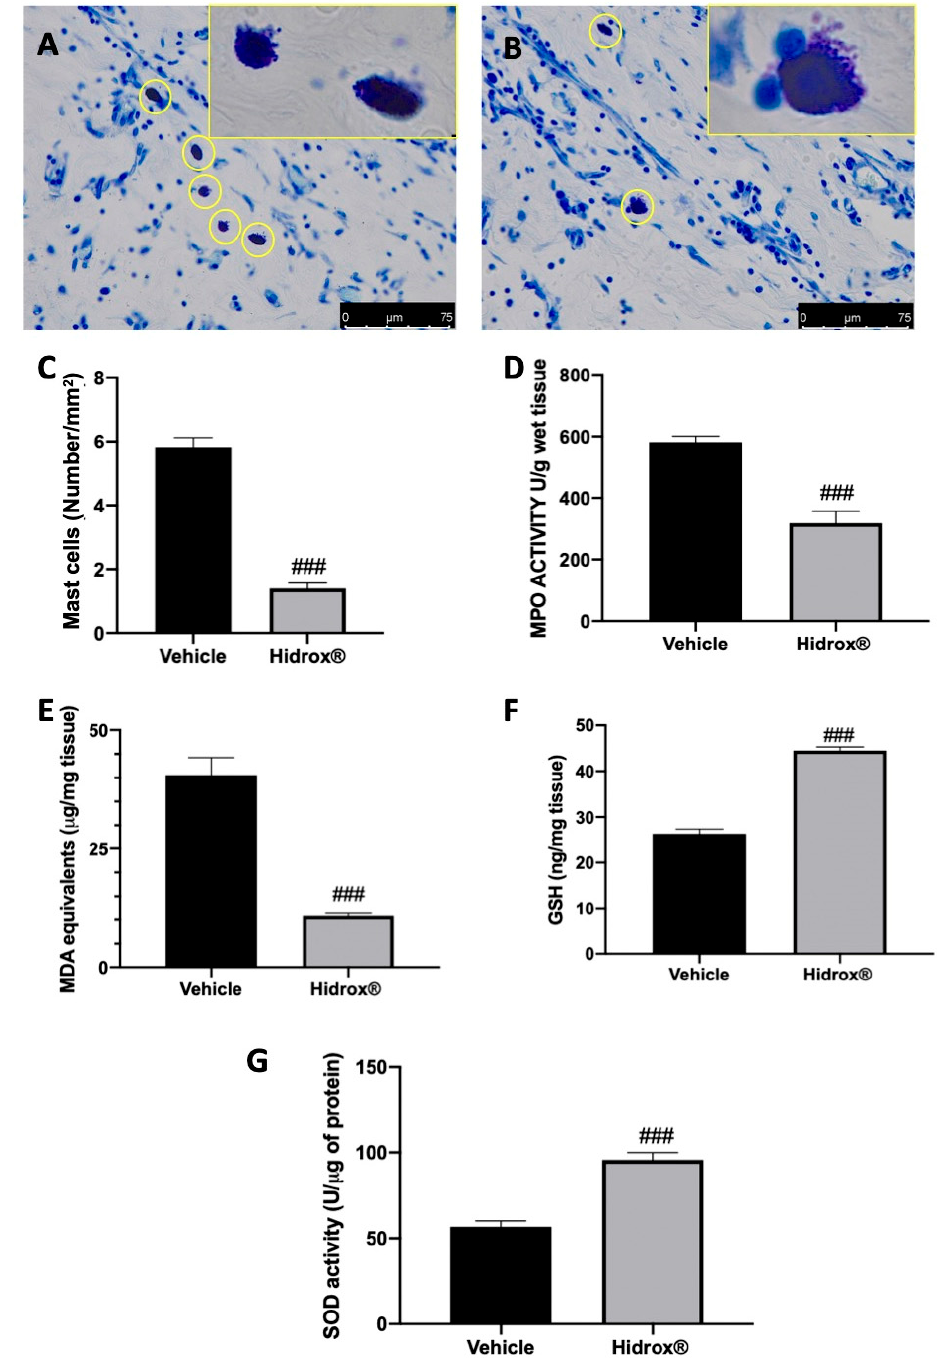
Figure 4. Hidrox ® administration reduced mast cell number and pro-oxidative alterations in endo- metrial explants: Toluidine blue staining of explanted lesions: vehicle ( A ), Hidrox ® ( B ), mast cell number ( C ), MPO activity ( D ), MDA levels ( E ), GSH levels ( F ), SOD activity ( G ). For the analyses, n = 5 animals from each group were employed. A p -value of less than 0.05 was considered significant. ### p < 0.001 vs. vehicle.